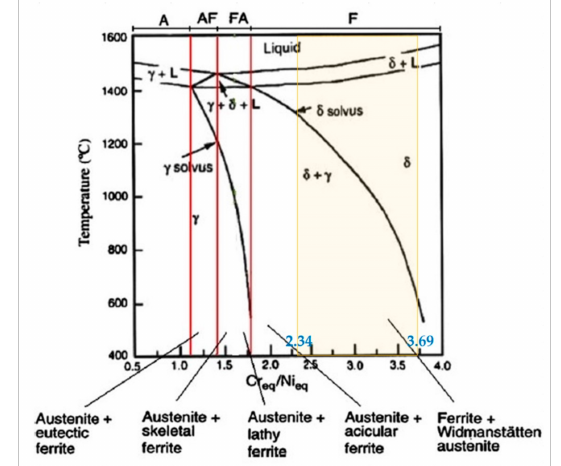
Figure 18. Pseudo-binary FeCrNi diagram at 70% Fe.